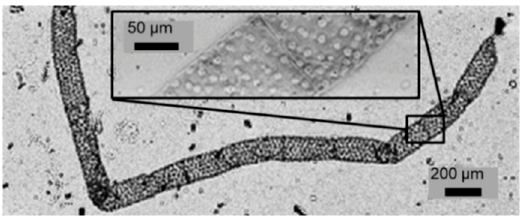
Figure 9. Image of a spirogyra alga recorded with the lens-free e-STOM setup using a 5 μ m LED microdisplay ( source 1 ). In the inset, image recorded with an intermediate lens reducing ×10 the LED image onto the specimen ( source 3 ).